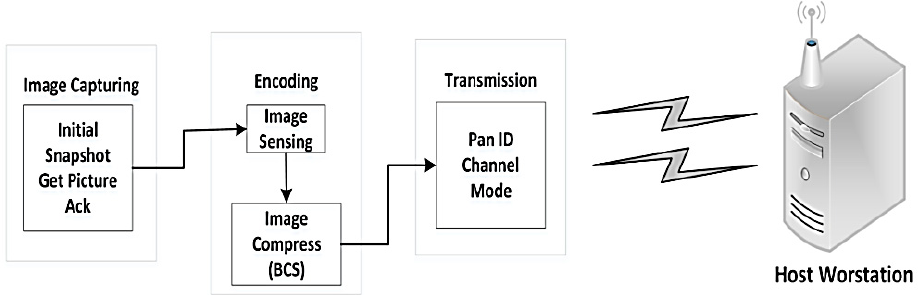
Figure 3. Software components associated with the visual node.